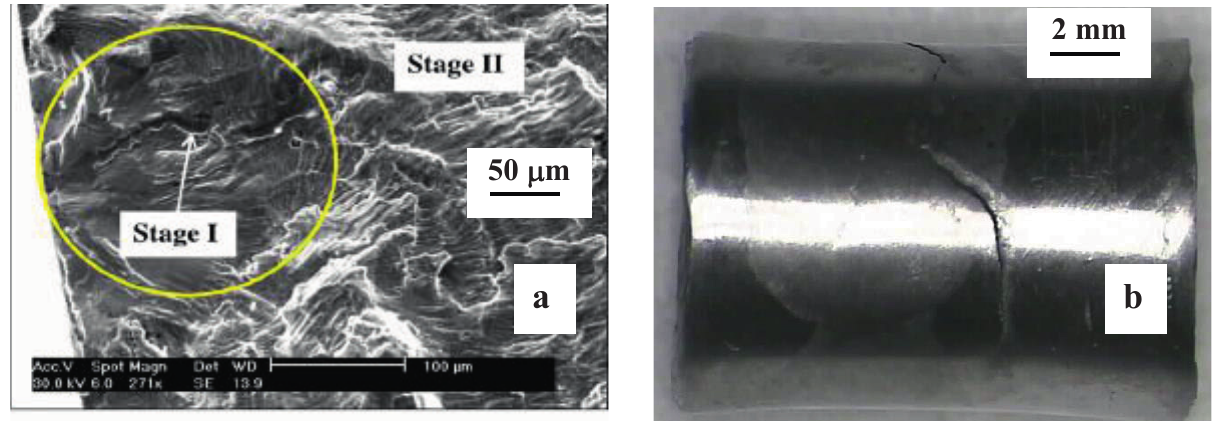
Figure 6. Crack initiation and propagation behaviour of weld joint specimens under (a) air environment and (b) flowing sodium